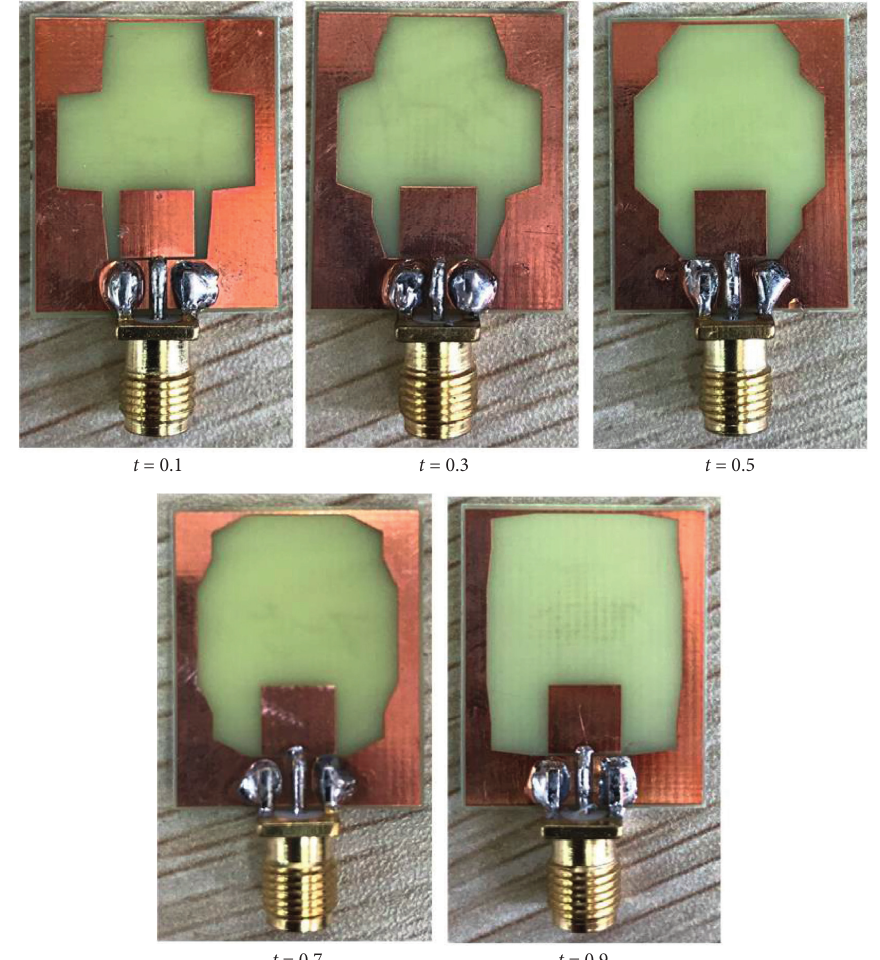
Figure 6: Photographs of antennas with different t